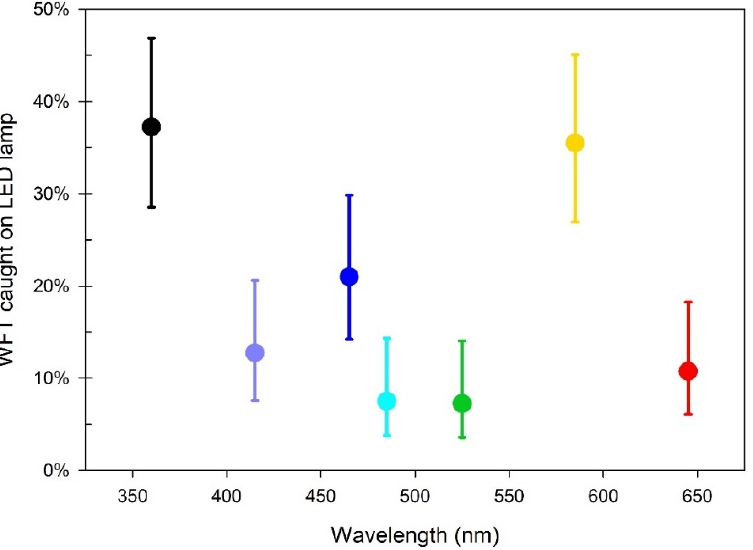
Figure 4. Experiment i : Mean percentage of Dutch WFT (NL c ) caught on the sticky glass plate of the LED lamp with different colours six hours after release. N = 4 replicates. Error bars are 95% confidence intervals. Peak wavelength of LEDs used: Pink (UV-A 369 nm), Violet (422 nm), Blue (477 nm), Cyan (502 nm), Green (529 nm), Yellow (588 nm), Red (651 nm). Each LED was presented as a single choice. All information from this figure is provided in Supplementary Table S6.